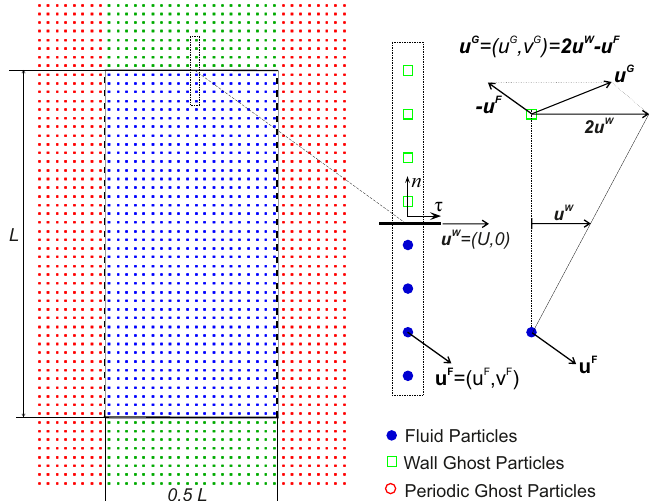
Figure 16. Couette and Poiseuille Flows: Particle layout ( left ). Schematic representation of the antisymmetric technique for wall ghost particles ( right